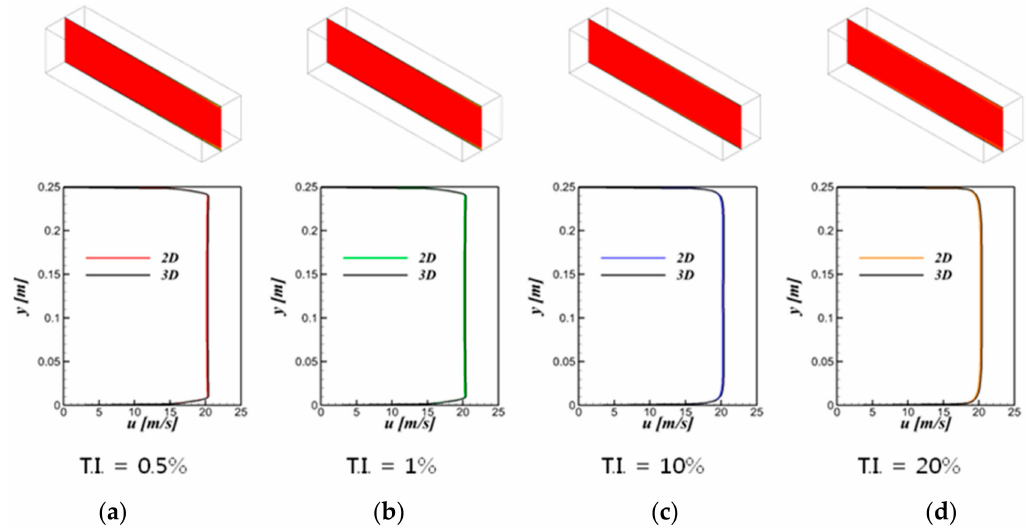
Figure 2. The comparison of 2D and 3D result for various turbulence intensities(TI); ( a ) 0.5%, ( b ) 1%, ( c ) 10%, ( d ) 20%.